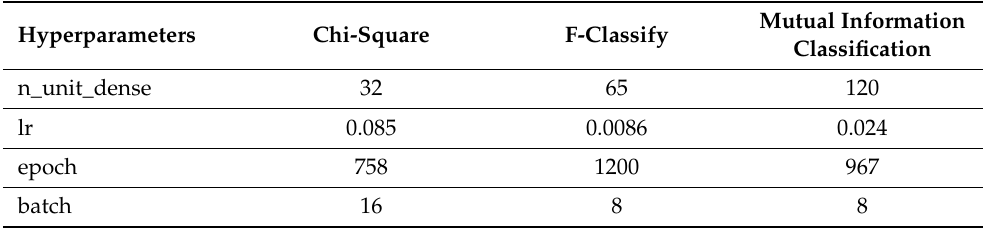
Table 6. Optimum values of hyperparameters of the neural network model that are trained using features selected by feature selection algorithms.